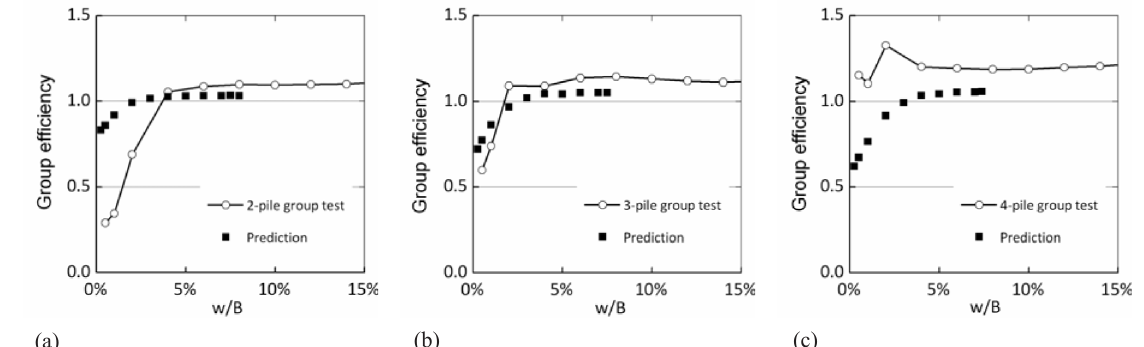
Fig. 15. Comparison of group efficiency calculated for measured and predicted pile group response in loose sand ( S/B = 3): (a) 2-pile group; (b) 3-pile group; (c) 4-pile